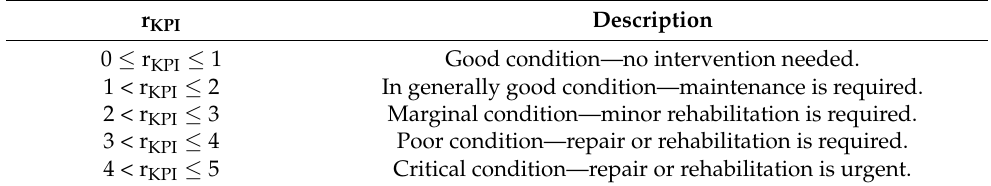
Table 7. Description of rating factor of the key performance indicators (r KPI